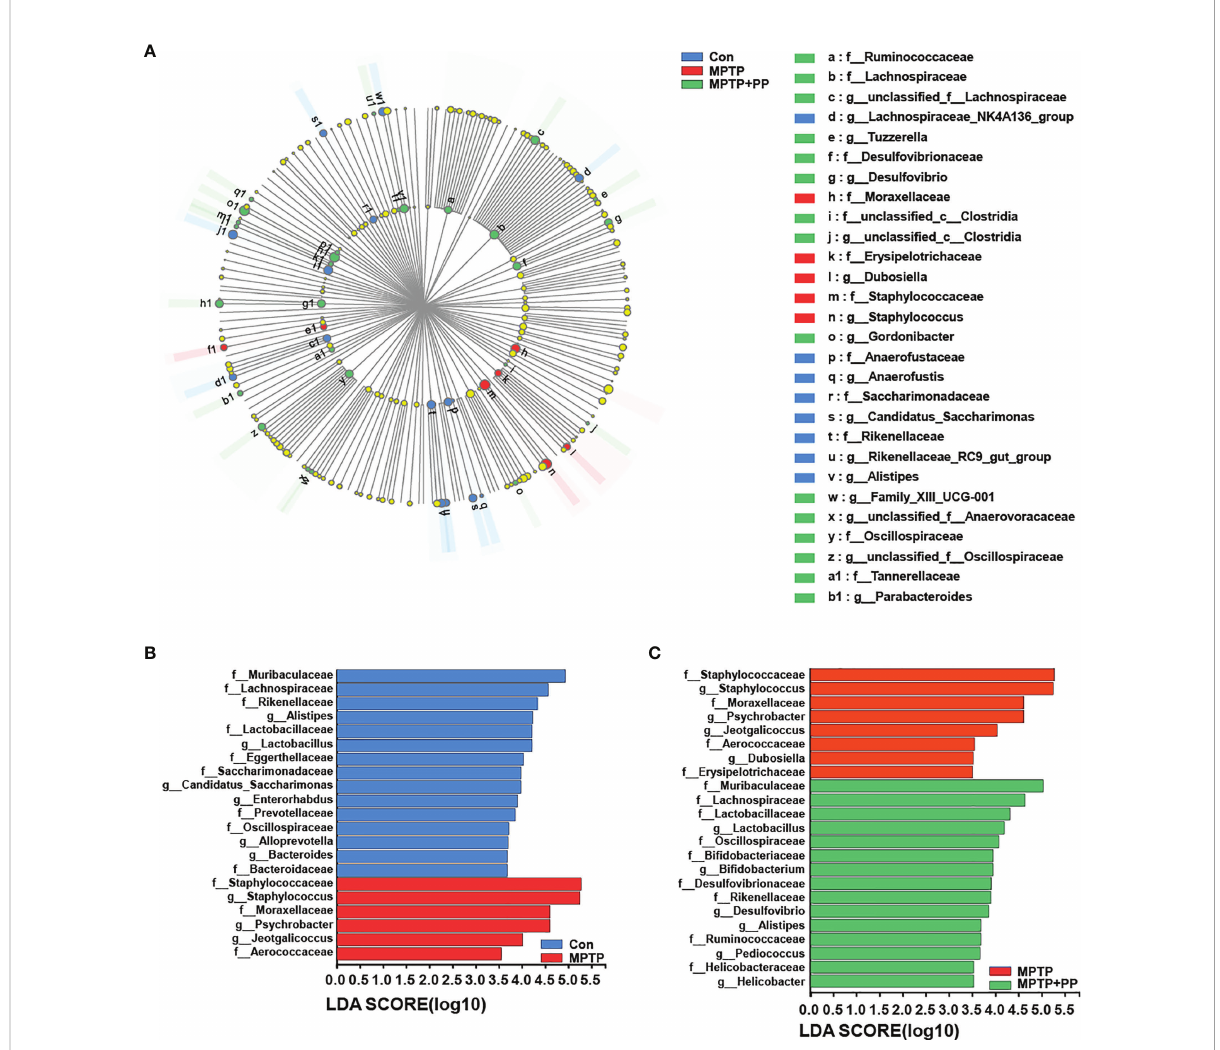
FIGURE 6 Pediococcus pentosaceus (PP) treatment changed the methyl-4-phenyl-1,2,3,6-tetrahydropyridine MPTP)-induced abnormal composition of speci fi c bacterial taxa. (A) LEfSe multilevel species hierarchy tree cladogram representing the microbial structure and the predominant bacteria among the three groups. (B) Microbial structure and the predominant bacteria between the Con group and MPTP group; linear discriminant analysis (LDA) > 3.5. (C) Microbial structure and the predominant bacteria between the MPTP group and the MPTP + PP group; LDA >